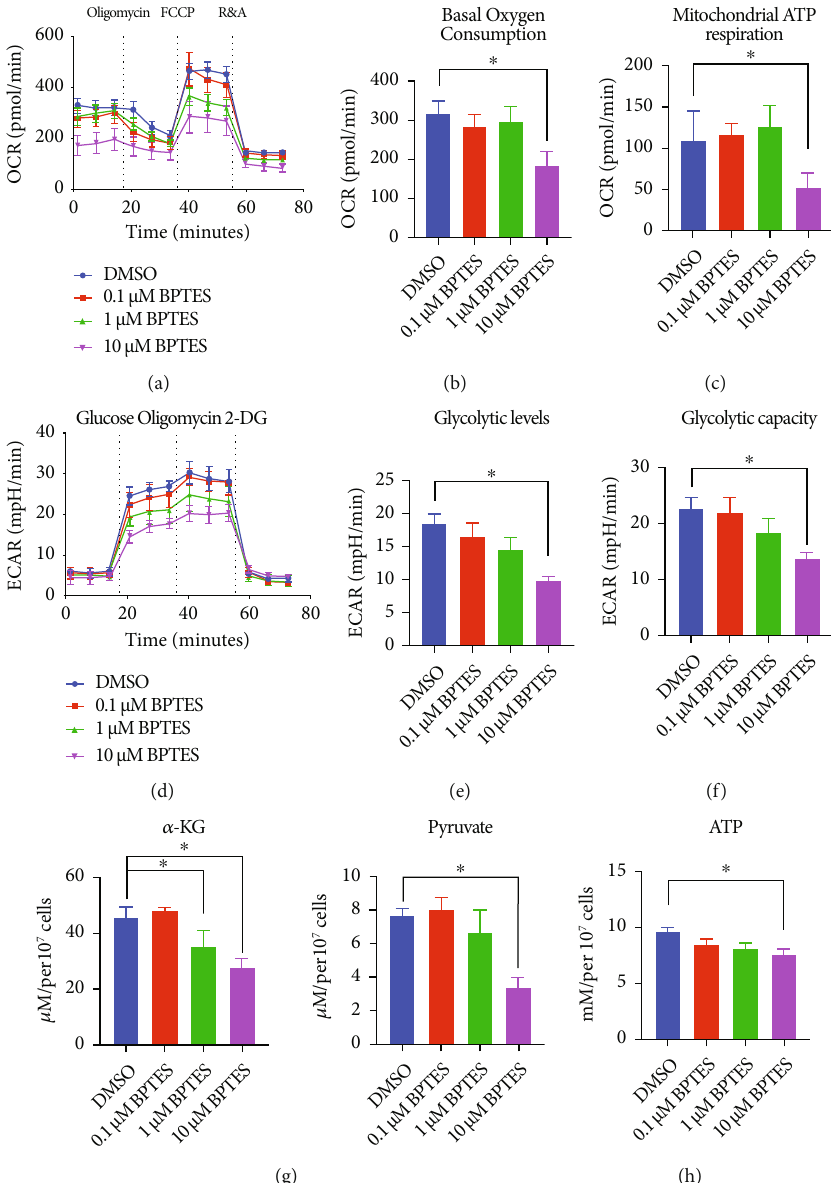
Figure 2: BPETS treatment normalized both glycolysis and OXPHOS in CD4+ T cells of SS-like NOD/Ltj mice. (a) The real-time OCR values in CD4+ T cells treated with 0.1 μ M to 10 μ M BPTES. (b) Measurement of basal oxygen consumption in CD4+ T cells treated with 0.1 μ M to 10 μ M BPTES. (c) Measurement of mitochondrial ATP respiration in CD4+ T cells treated with 0.1 μ M to 10 μ M BPTES. (d) The real-time ECAR values in CD4+ T cells treated with 0.1 μ M to 10 μ M BPTES. (e) Measurement of the basal glycolytic levels in CD4+ T cells treated with 0.1 μ M to 10 μ M BPTES. (f) Measurement of glycolytic capacity under stress in CD4+ T cells treated with 0.1 μ M to 10 μ M BPTES. (g) Measurement of α -KG and pyruvate concentration in CD4+ T cells treated with 0.1 μ M to 10 μ M BPTES. (h) Measurement of ATP concentration in CD4+ T cells treated with 0.1 μ M to 10 μ M BPTES. Summary data are presented as ∗ p < 0 : 05 with unpaired two-tailed Student ’ s t